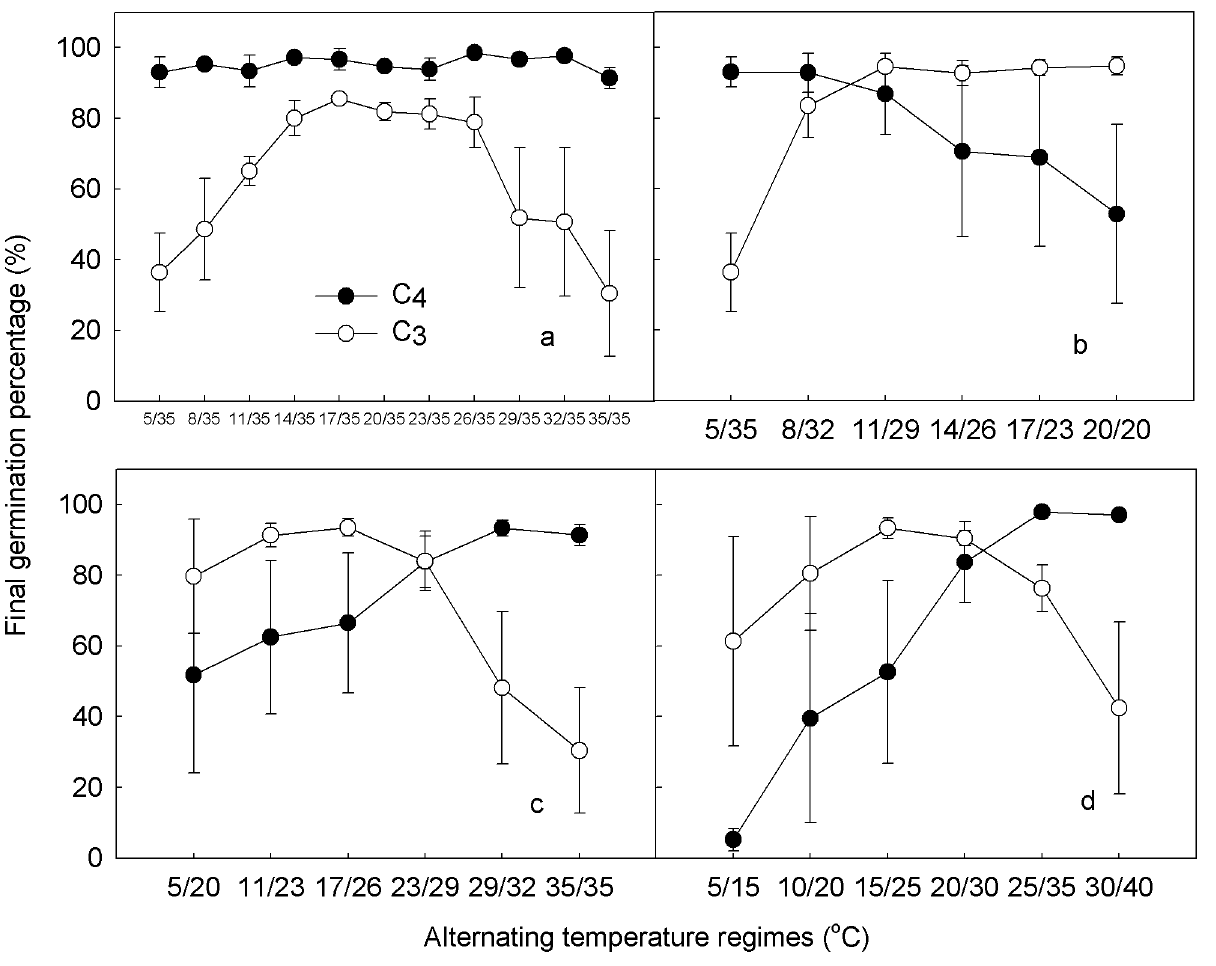
Figure 1. Germination percentages of C 4 (closed circles, average of E.crusgalli , P.oleracea and A.retroflexus ) and C 3 species (open circles, average of L.myosotis , S . amara and C . chinense ) under different alternating temperature regimes (a, TmaxC; b, TaveC; c, AW; d, SW). Mean 6 S.E.